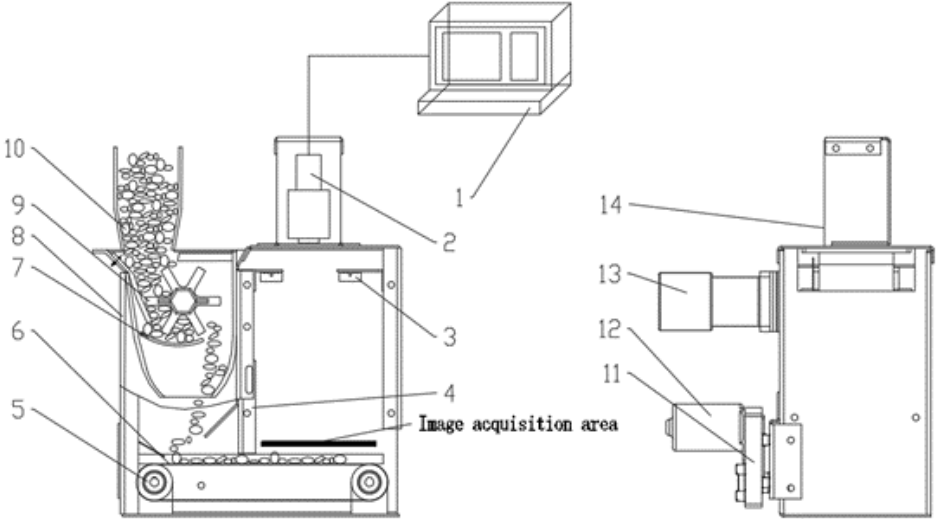
Figure 2. Discrete tile sampling mechanism for corn harvested kernels. (1) Industrial computer, (2) industrial camera, (3) LED light source, (4) adjustable baffle, (5) gear shaft, (6) timing belt, (7) discharge tongue, (8) collection box, (9) outer sheaf, (10) corn kernels, (11) reducer, (12) DC motor, (13) stepper motor, and (14) camera fixing shell.